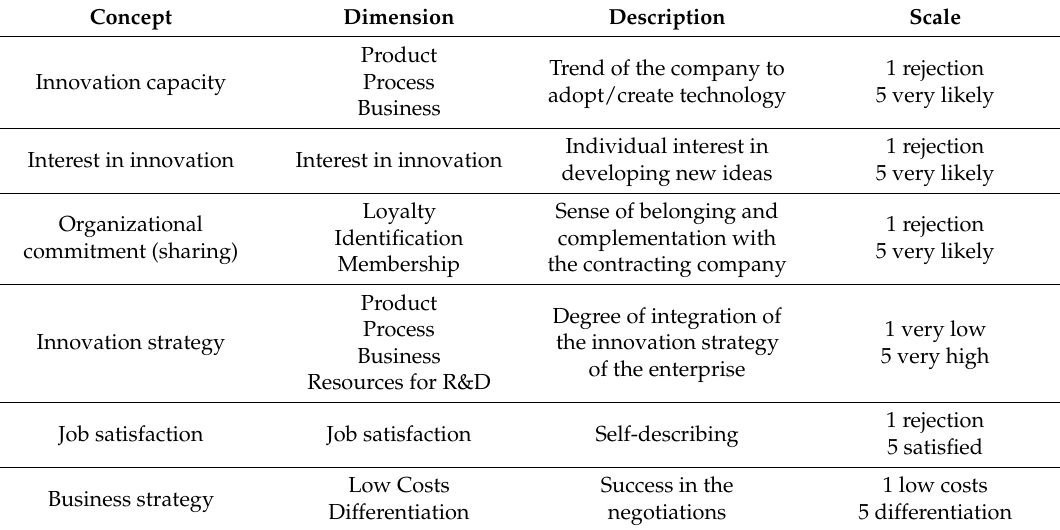
Table 1. Criteria and parameters for the evaluation of